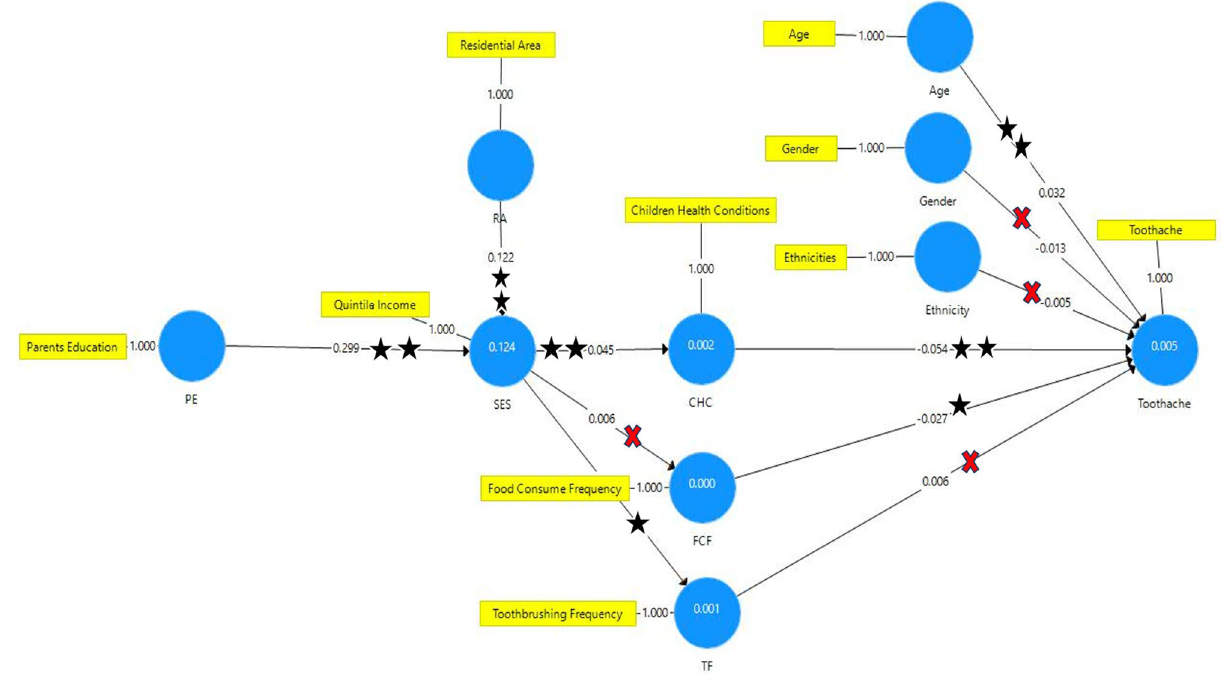
Figure 2. Structural equation model